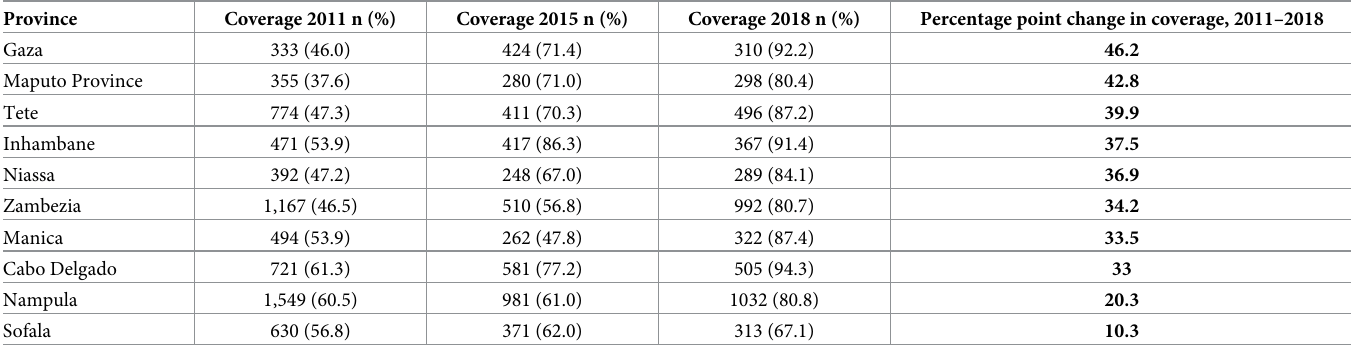
Table 1. Trends in household ownership coverage of ITNs in 10 provinces of Mozambique in 2011, 2015, and 2018, from the 2011 DHS, 2015 AIS, and 2018 MIS.